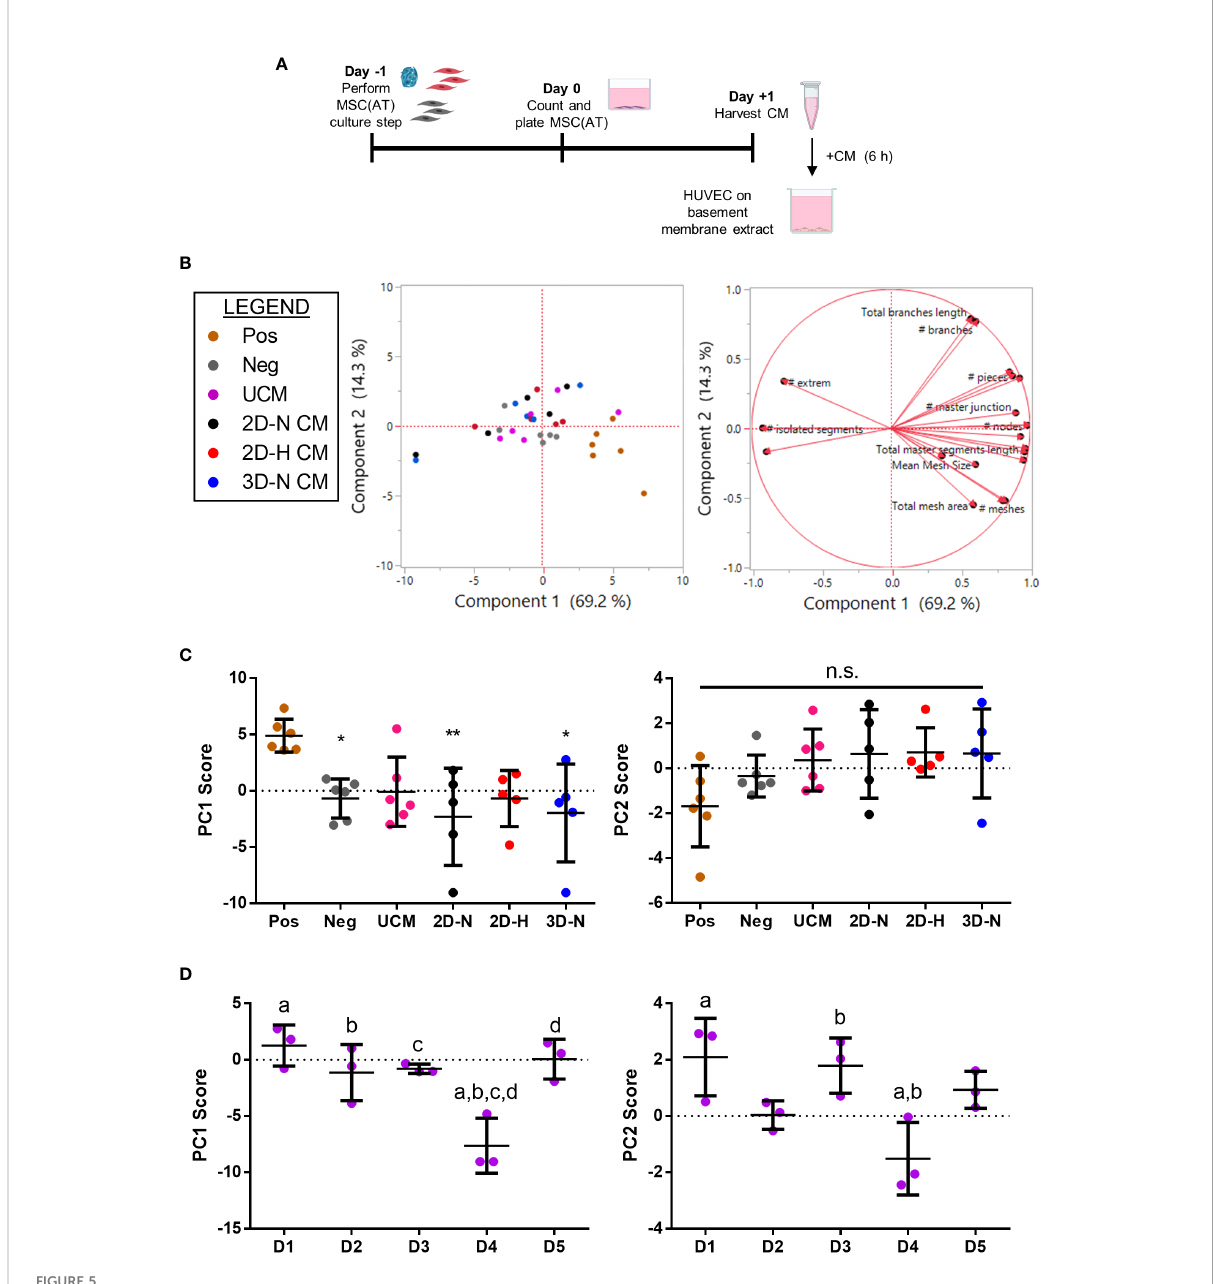
FIGURE 5 In vitro MSC(AT) mediated functional angiogenic HUVEC tube formation assay was differentially sensitive to donor heterogeneity and CPPs. (A) Schematic of experimental set-up for the tube formation assay. Conditioned medium (CM) was collected from MSC(AT) (2D-N, 2D-H, or 3D-N) after 24 h of incubation and added to HUVECs cultured on basement membrane extract for 6 h. (B) Principal component (PC) analysis of fold- change values (relative to negative control) of twenty HUVEC tube formation image analysis readouts (left). The corresponding loading plot of eigenvectors (right) indicates the relative contribution of each factor to the PCs. (C) Principal component scores for PC1 and PC2 according to culture condition. The positive control group (Pos; HUVECs cultured in pro-angiogenic medium) displayed signi fi cantly higher PC1 scores relative to the negative control (Neg; HUVECs cultured in basal medium), and to HUVECs cultured with conditioned medium derived from 2D-N or 3D-N MSC(AT) culture conditions. One-way ANOVA, Tukey post-hoc test. *p<0.05, **p<0.01 relative to positive control. (D) Principal component scores for PC1 and PC2 according to MSC(AT) donor heterogeneity. Statistically signi fi cant differences between donors were observed for PC1 and PC2 scores and are indicated by donors sharing the same letter. One-way ANOVA, Tukey post-hoc test, p<0.05. N=5 MSC(AT) donors, n=2-3 technical replicates/condition. Horizontal bars: group mean, error bars: standard deviation. HUVEC, human umbilical vein endothelial cell; Pos, positive control; Neg, negative control; UCM, unconditioned medium; 3D-N, 3D Normoxic culture; 2D-N, 2D Normoxic culture; 2D-H, 2D Hypoxic culture; CM, conditioned medium; n.s., statistically non-signi fi